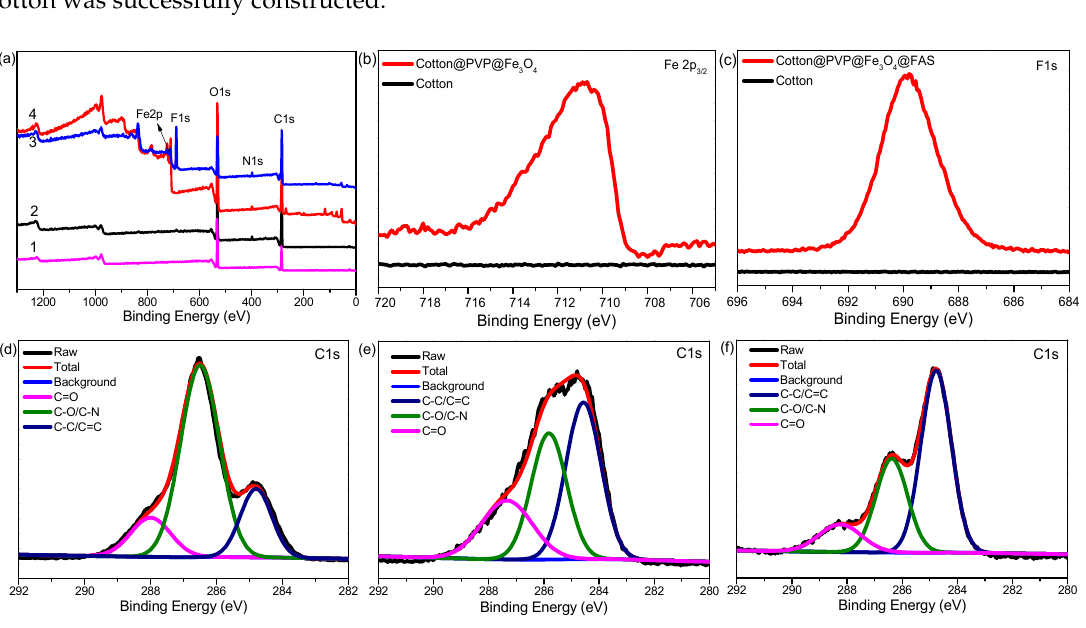
Figure 3. ( a ) XPS survey spectra of pristine cotton fabrics (a1), PVP ‐ modified cotton (a2), Fe 3 O 4 ‐ modified cotton (a3), Fe 3 O 4 ‐ modified cotton after fluorination treatment (a4); ( b ) high ‐ resolution spectra of Fe 2p of pristine cotton and cotton@PVP@Fe 3 O 4 composites; ( c ) F 1s of pristine cotton and